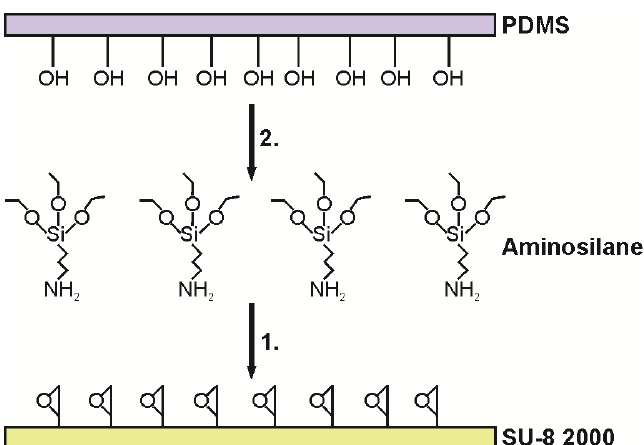
Figure 3. Schematic molecular level representation of the bonding process between the SU-8 and PDMS surface: 1. Silanization of the SU-8/2. OH groups of hydrolized APTES molecules react with the silanol groups of plasma treated PDMS surface.